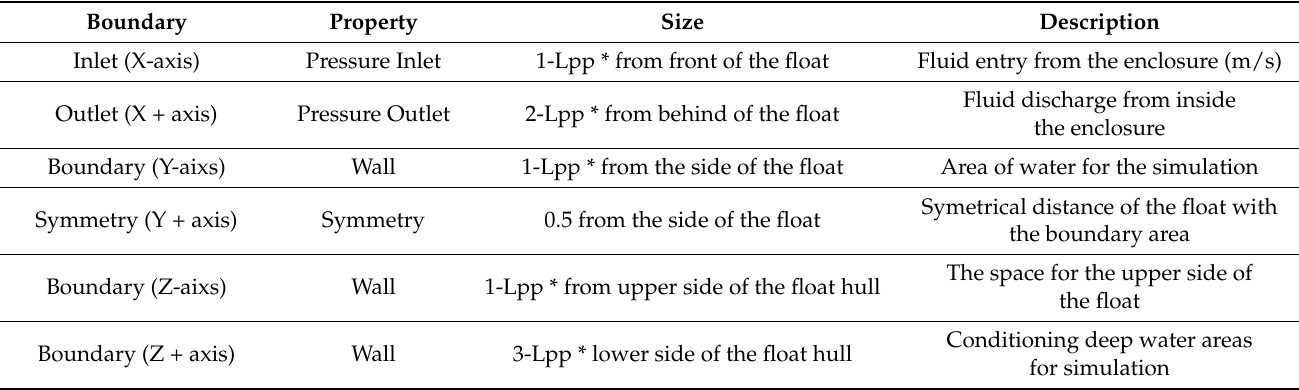
Table 3. Boundary location for computational fluid